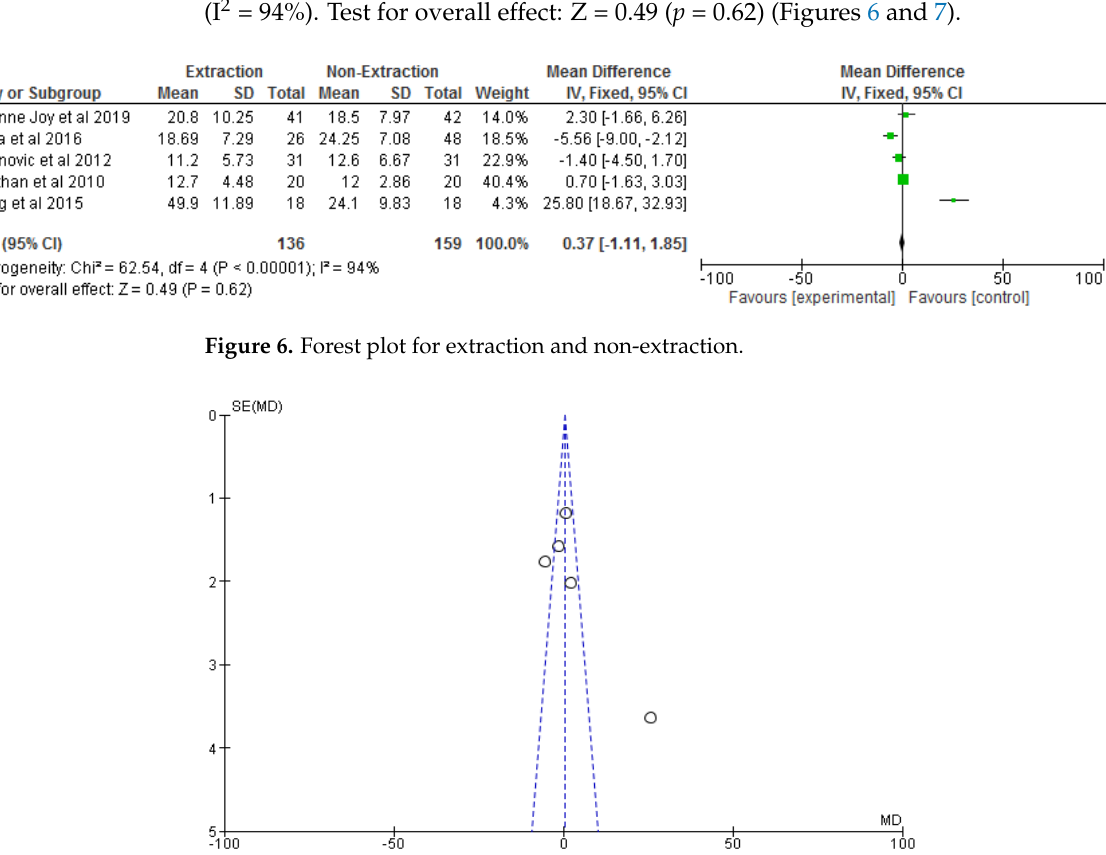
Figure 7. Funnel plot for extraction and non-extraction.